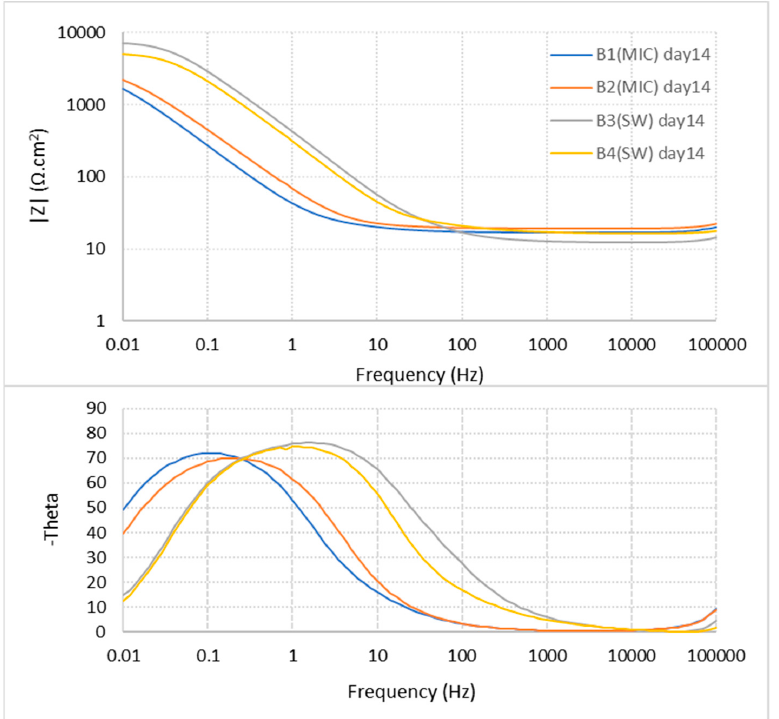
Figure 7. Nyquist ( a ) and Bode ( b ) impedance plots for samples exposed to SW (B3, B4) and to SW + bacteria (B1, B2 MIC) for 14 days.